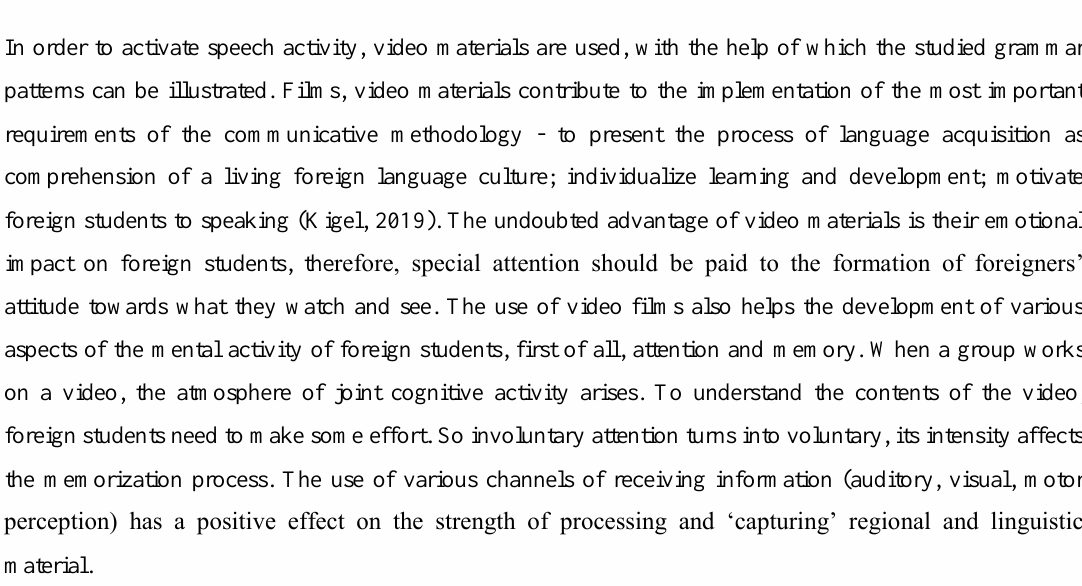
Figure 5. Fragment of the task with linguocultural orientation to train grammar